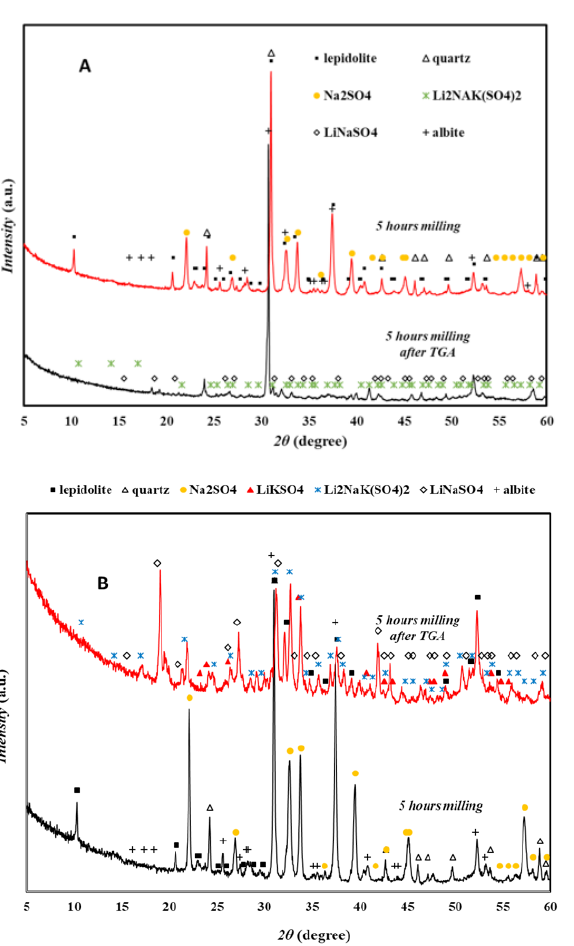
Fig. 3 . XRD patterns of TGA solid residues for lepidolite- -Na SO mixtures with mass ratios of 1 : 0.5 (A) 2 4 and 1:1 (B)